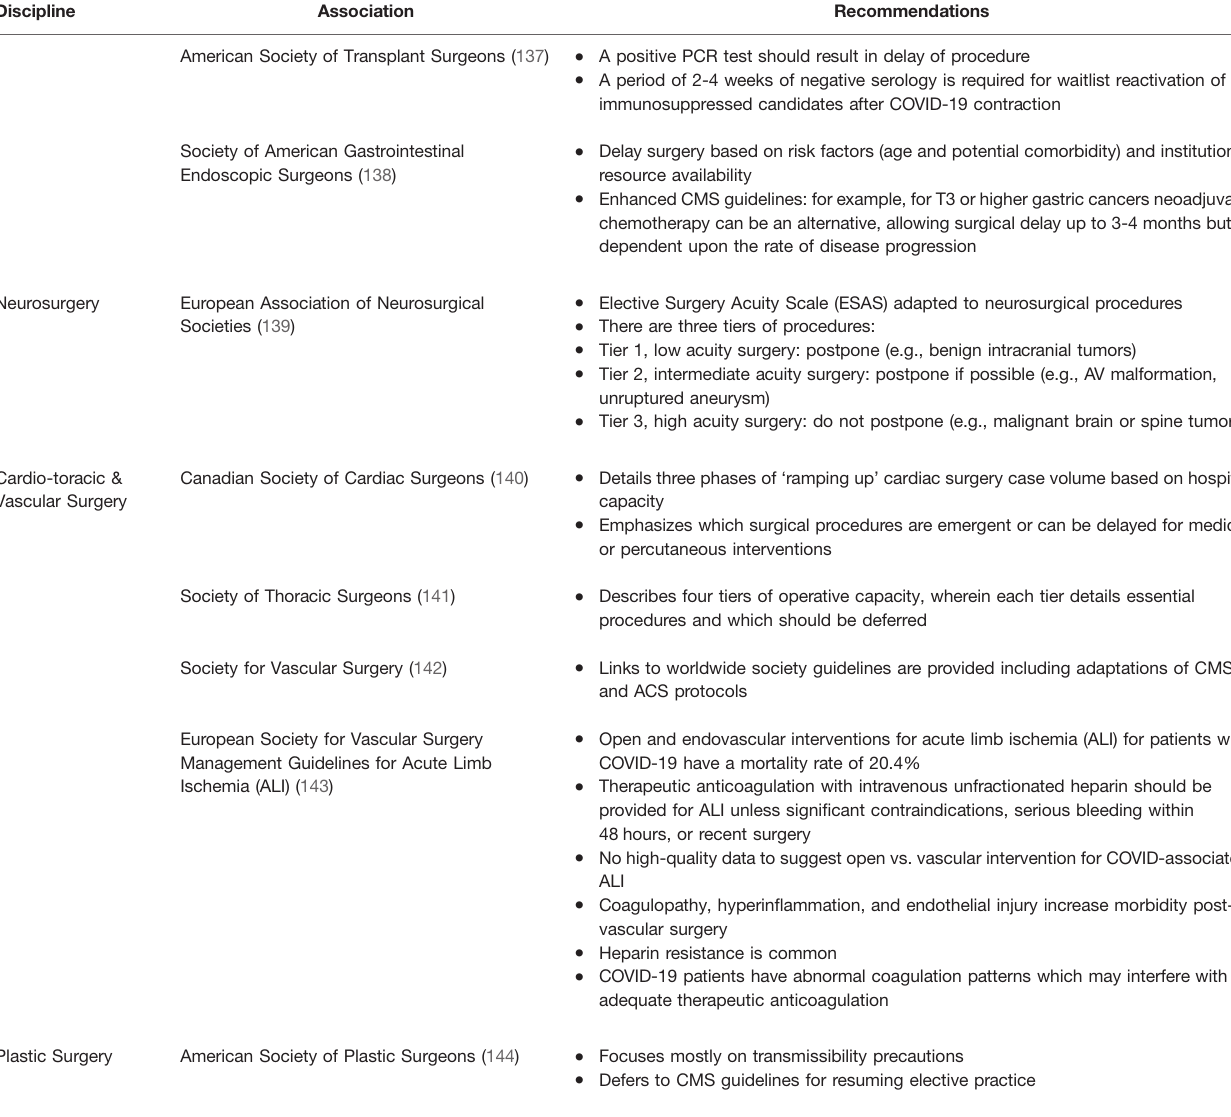
in Table 2 . The American Association for Hand Surgery suggests delaying surgery based on the capacity to care for COVID-19 patients rather than postoperative prognosis